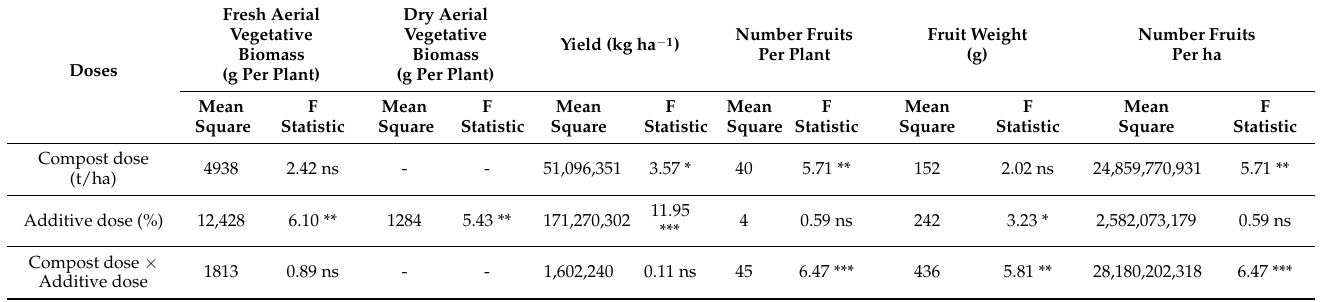
Figure 2. Responses of several agronomic variables to the treatments applied in the field trial for the pepper crop: yield ( A ), its components ( B – D ), fresh aerial vegetative biomass ( E ) and dry aerial vegetative biomass ( F ). The values are expressed as relative values in percentage, using, as a reference (100%), control 80. Comparison against control 80 was performed with the Dunnett test (* means significant difference at p ≤ 0.05 with the control 80, ns means not significant difference at p ≤ 0.05 with the control 80). Table 3. ANOVA for yield, yield components and biomass production in the pepper crop. The location, the year and the plot were considered random factors, whilst the compost dose and the additive (PGPR + biochar) dose were fixed factors (significance level: *** p ≤ 0.001; ** 0.001 < p ≤ 0.01; * 0.01 < p ≤ 0.05; ns, not